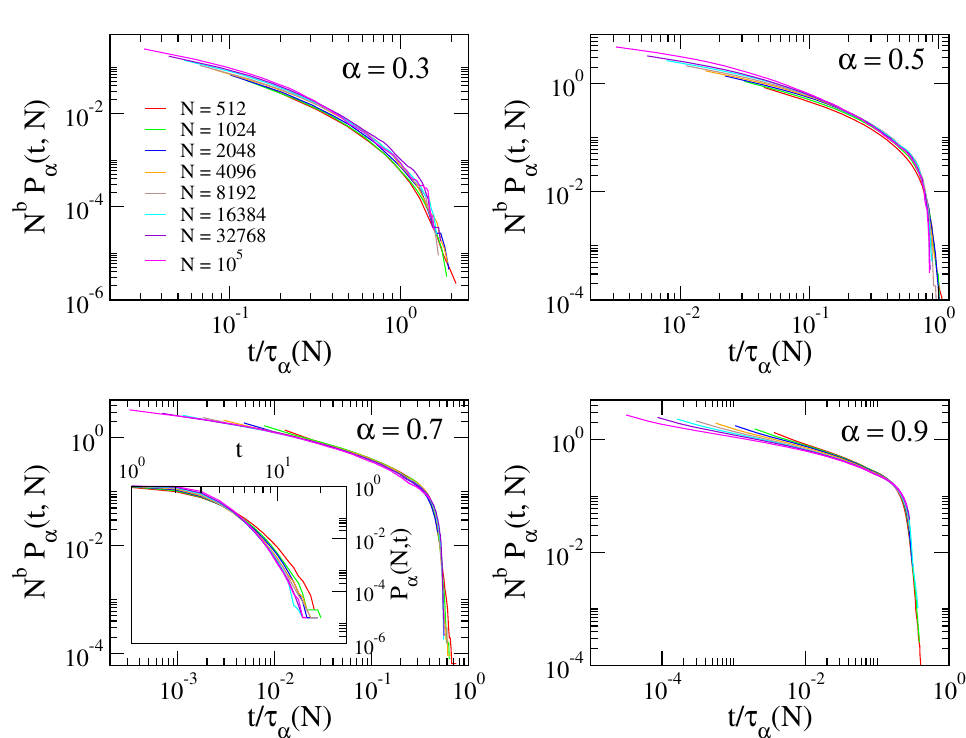
Figure 3: N b P α ( t , N ) is plotted against t /τ α ( N ) on a log-log scale, for different values of α ( α = 0.3,0.5,0.7,0.9 in the upper left, upper right, lower left and lower right panels, respectively) and various N , see keys. b as in Eq. (18) and τ α ( N ) as in Eq. (13). Each curve is averaged over 10 7 realisations for α = 0.3, over 10 6 for α = 0.5, and over 10 5 for α = 0.7 and α = 0.9. The inset in the lower left